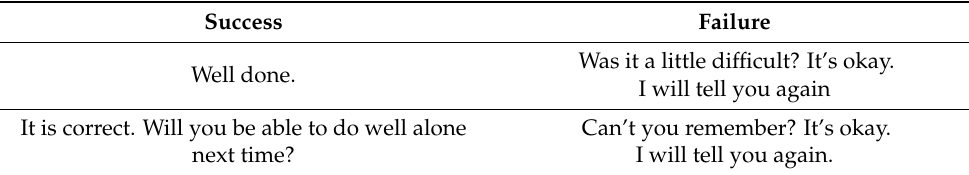
Table 1. Examples of voice feedback.